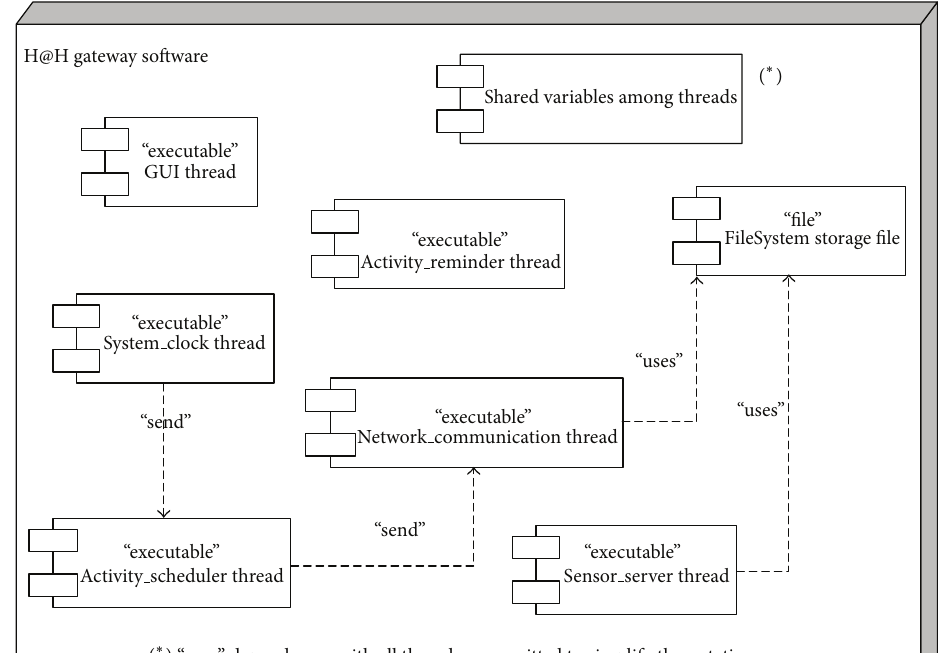
Figure 6: Components diagram of the gateway application software.